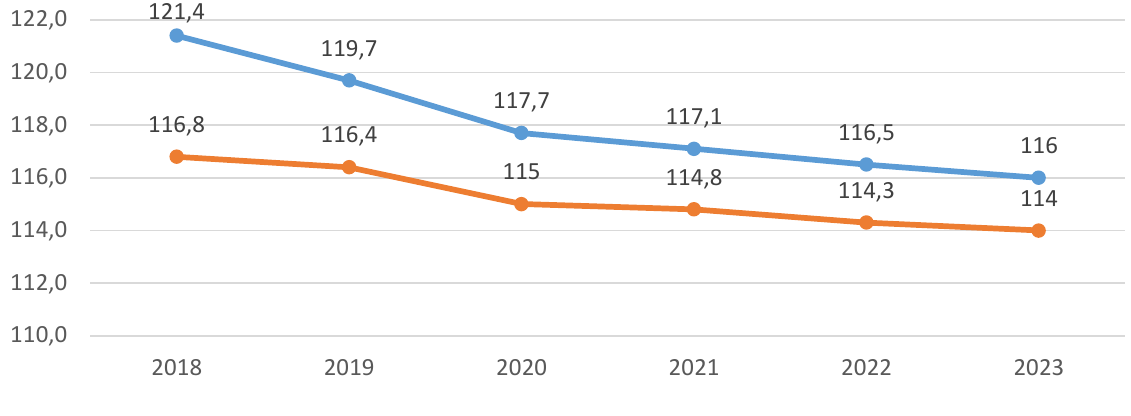
Rate of growth (slowdown) of workplace creation in industry, % Rate of growth (slowdown) of workplace creation in the processing industry,